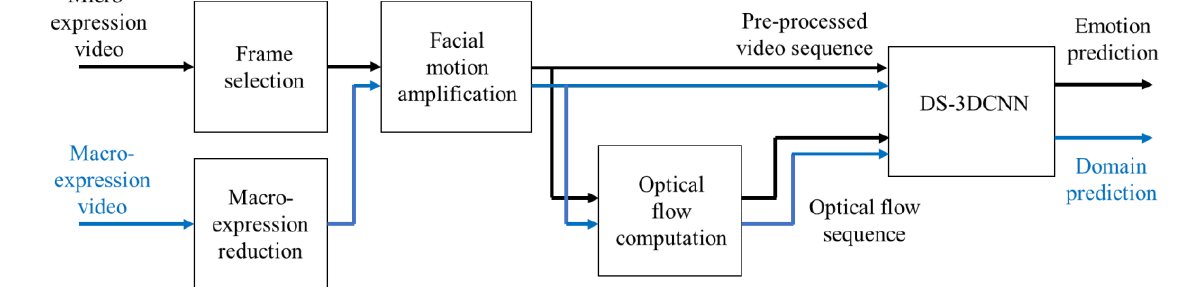
Figure 1. Overview of our proposed MER framework.